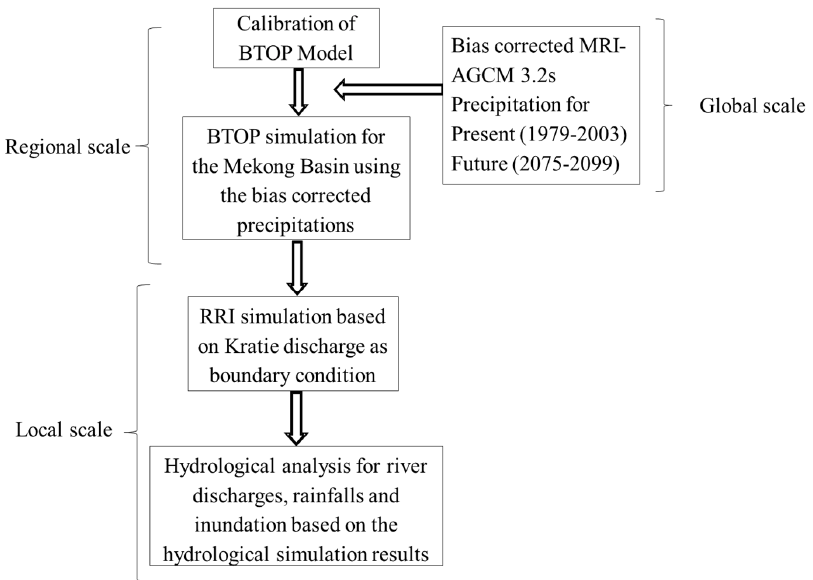
Figure 2. Flowchart of the modelling process.